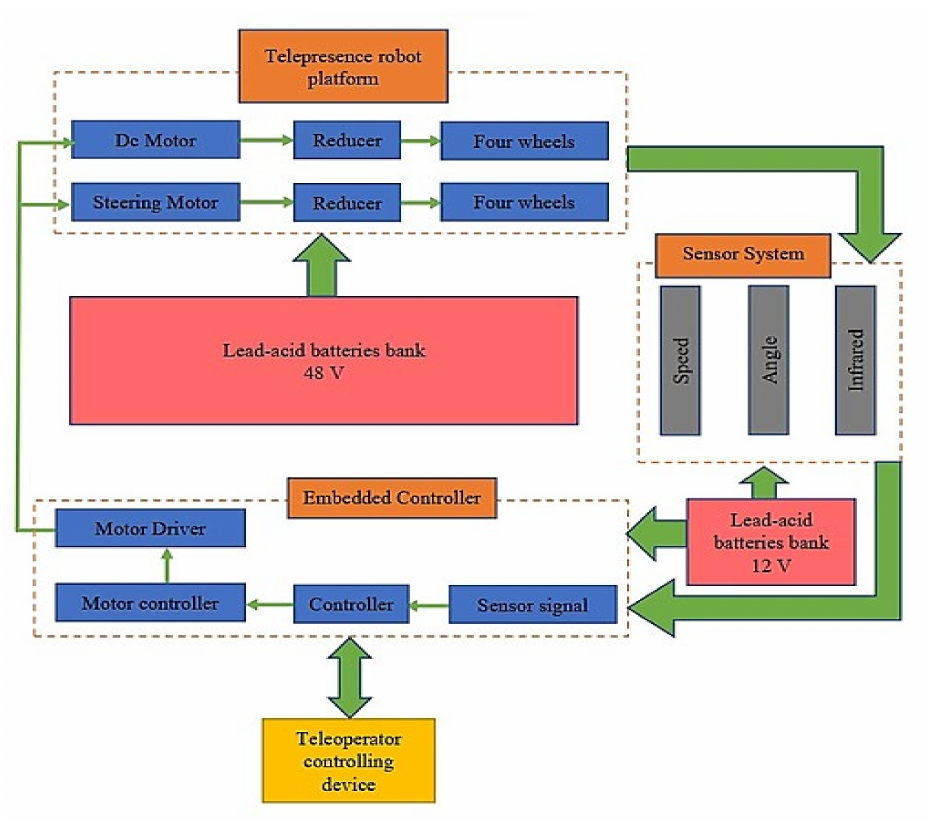
Figure 5. System Block Diagram of Telepresence